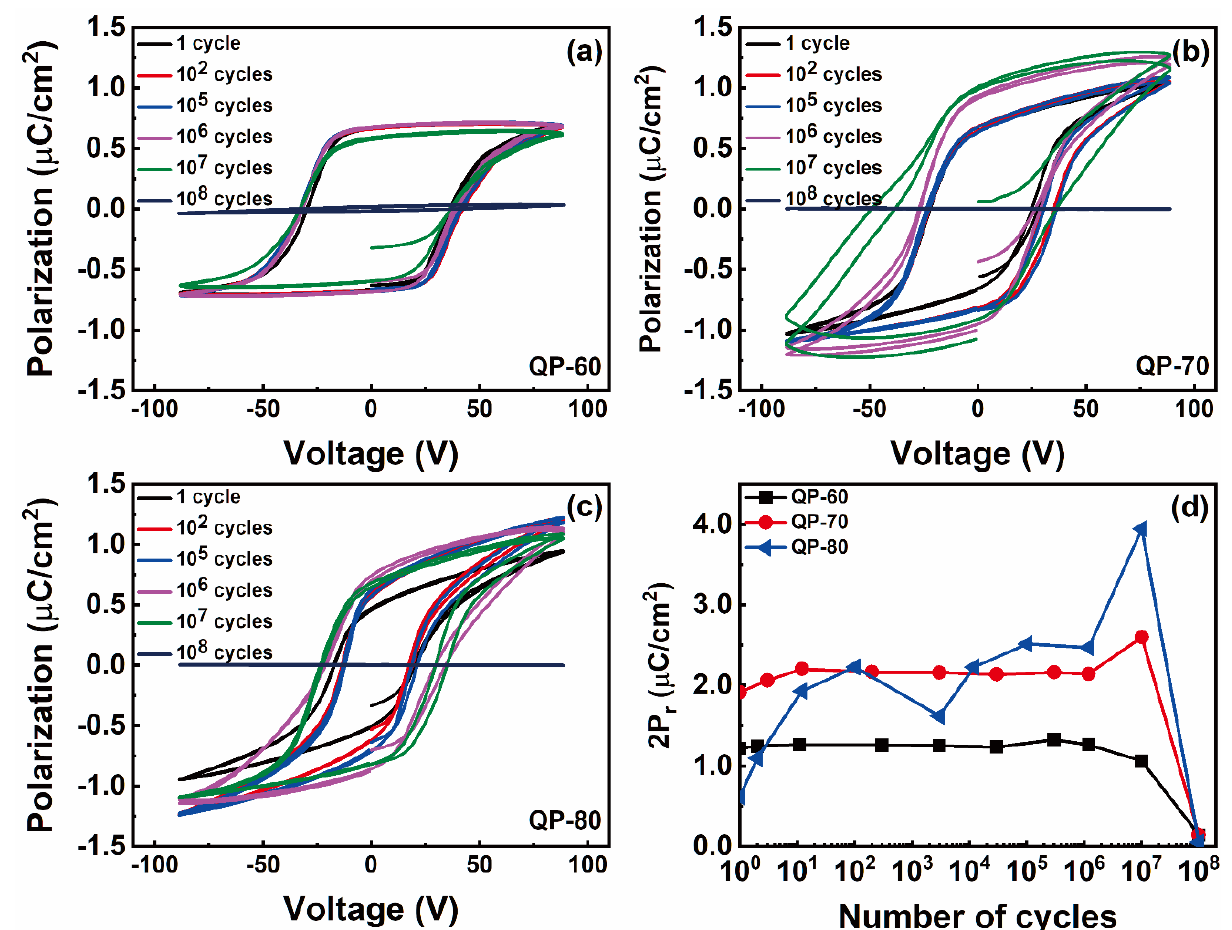
Figure 5. Field cycling and fatigue response for ( a ) Au/QP-60/ITO, ( b ) Au/QP-70/ITO, and ( c ) Au/QP-80/ITO capacitors. ( d ) The variation in 2P r values with the electric field cycling.